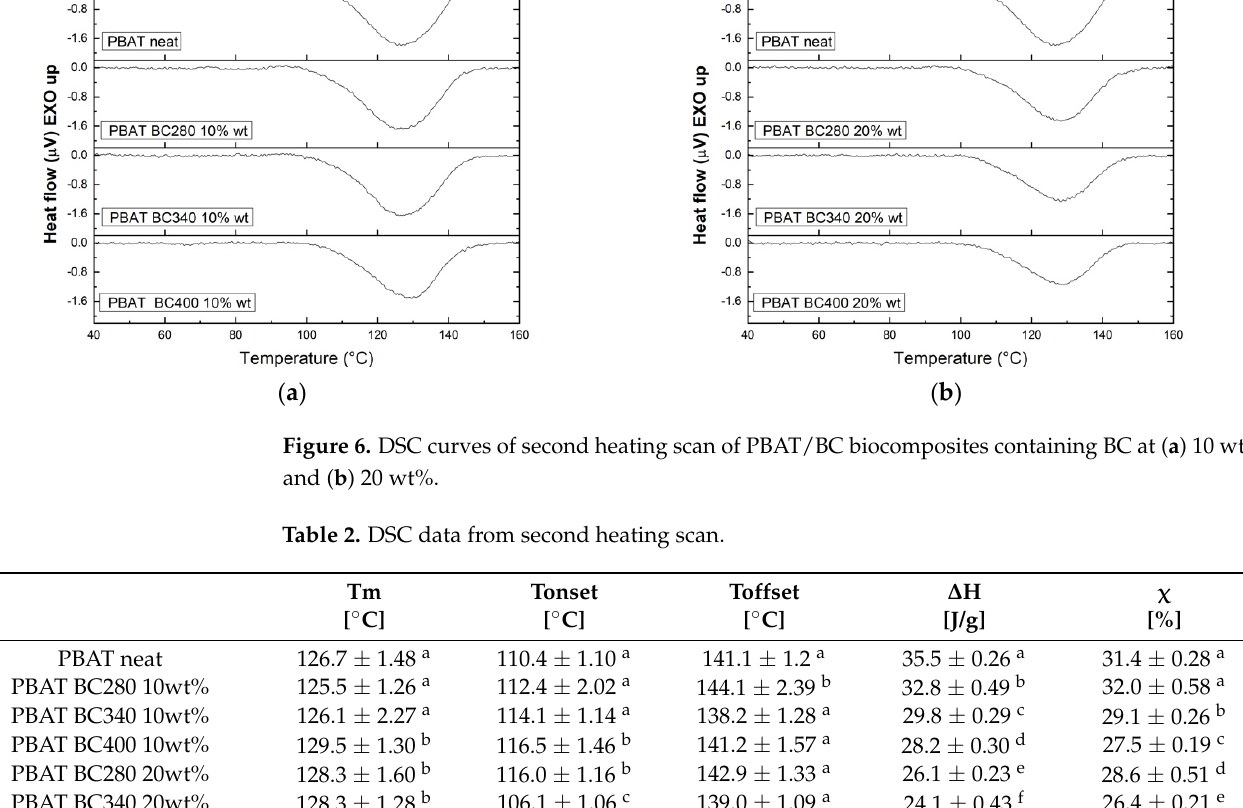
Figure 6. DSC curves of second heating scan of PBAT/BC biocomposites containing BC at ( a ) 10 wt%. and ( b ) 20 wt%.